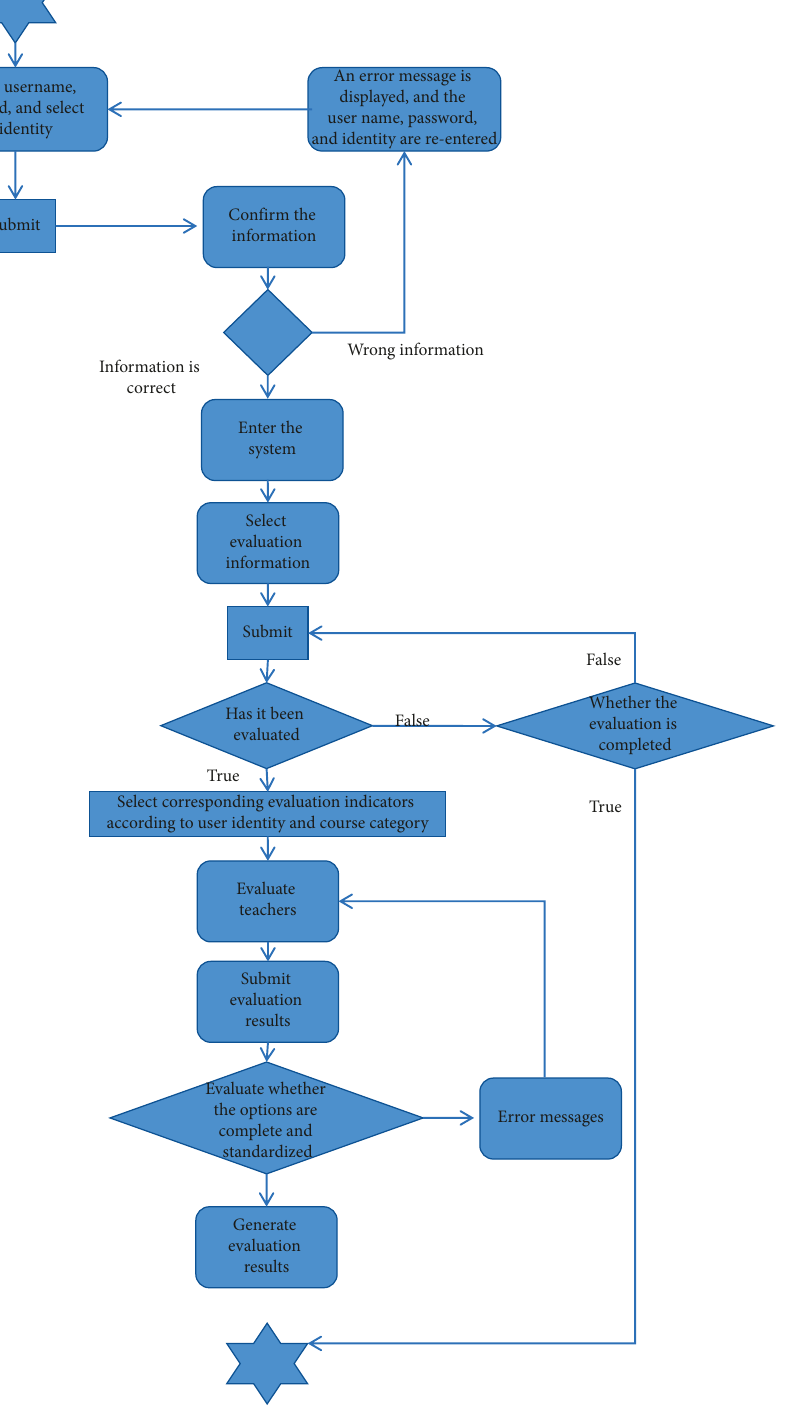
Figure 5: User online evaluation activity